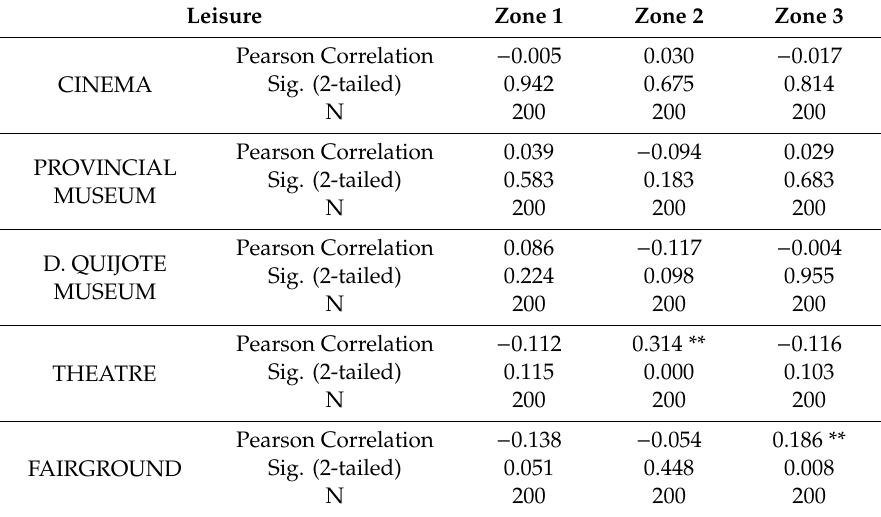
Table 4. Results of answers related to leisure heritage.